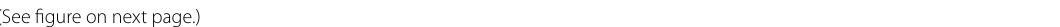
figure(See figure on next Fig. 3 Heatmap of abundance of endophytic fungi (top) and bacteria (bottom) of C. equisetifolia seeds, branchlets, roots, and litter at genus taxonomic levels. The abscissa is the sample name, and the ordinate is the species name. The clustering tree above the Heatmap represents the differences between samples, and the clustering tree on the left of the Heatmap represents the differences between microbes, with clustering into one group meaning that the differences are small. The variation of the abundance of different species in the sample is displayed through the color gradient of the color block. The value represented by the color gradient is on the right of the